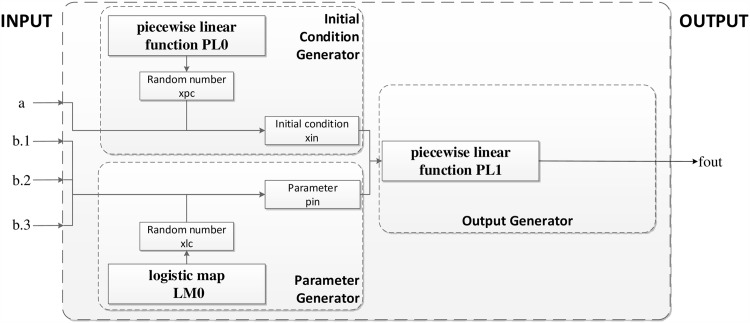
Round function of [33] for one color of one pixel.